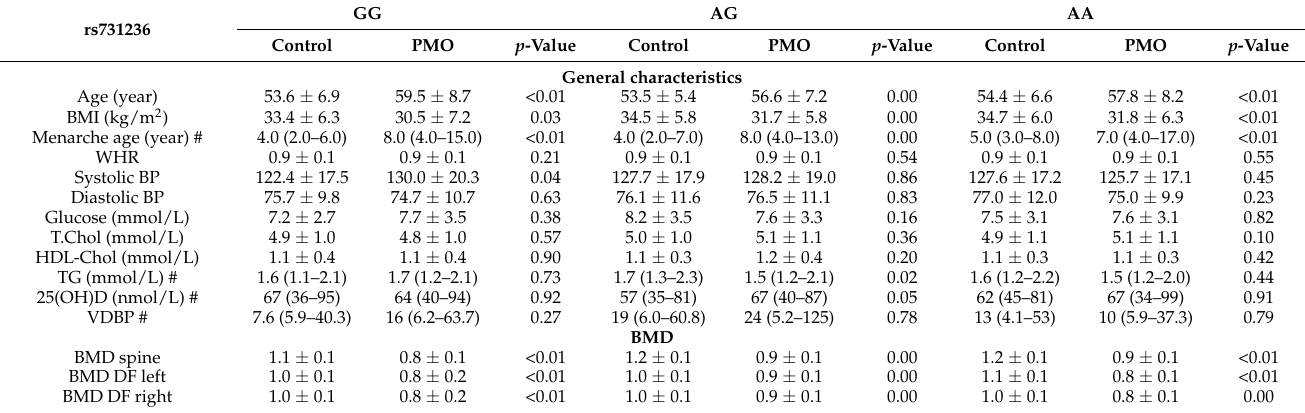
Table 3. Associations between rs731236 genotypes and various other